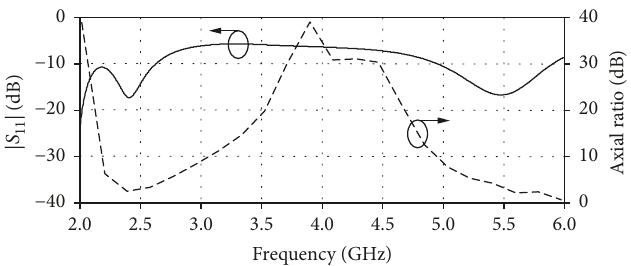
Figure 6: Simulated results of the truncated square patch antenna with slant strip and L-shaped